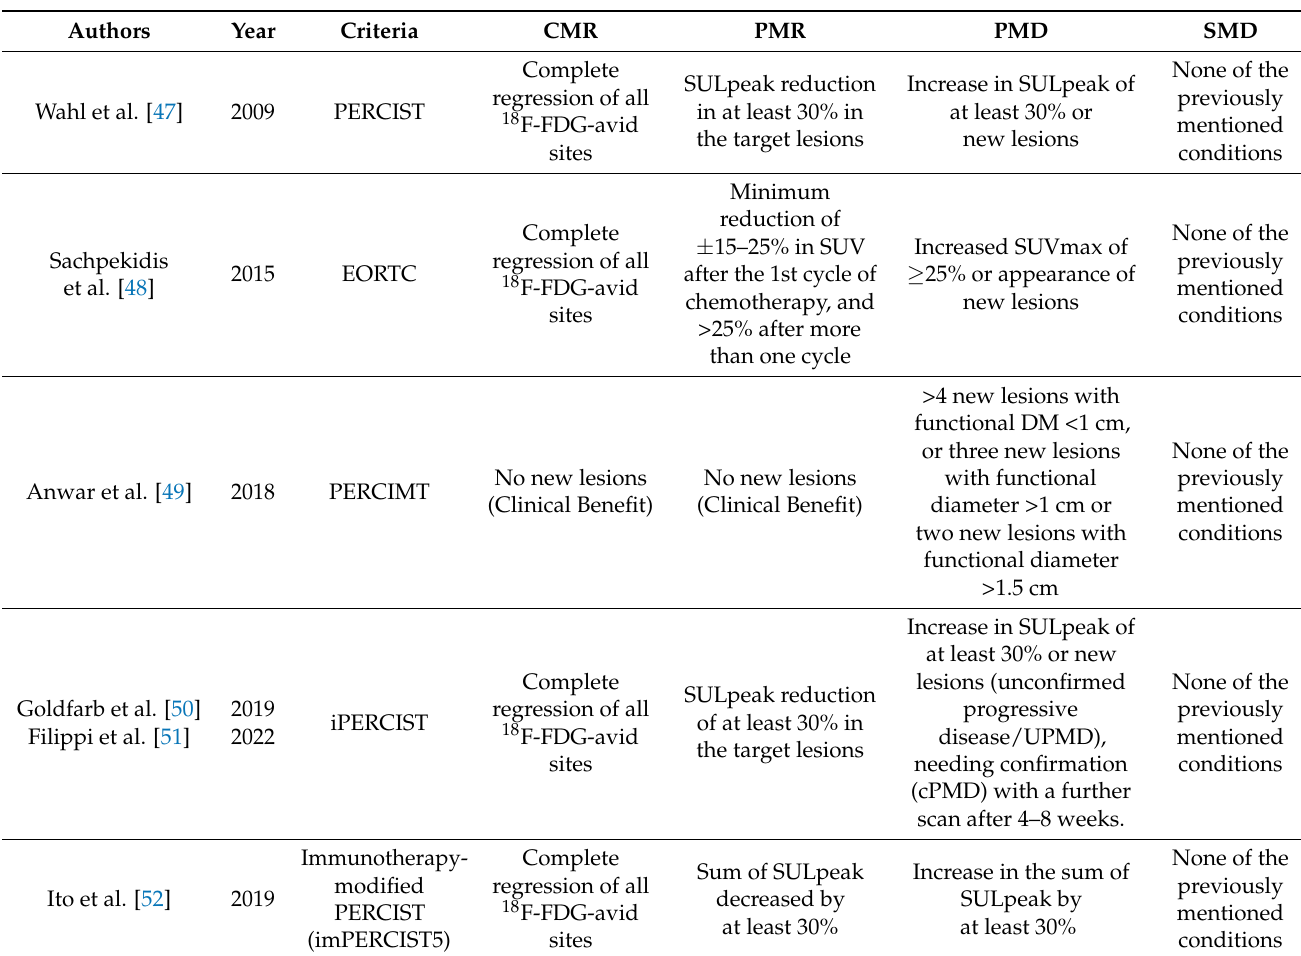
Table 3. Main metabolic criteria applied for the assessment of response to immunotherapy in skin